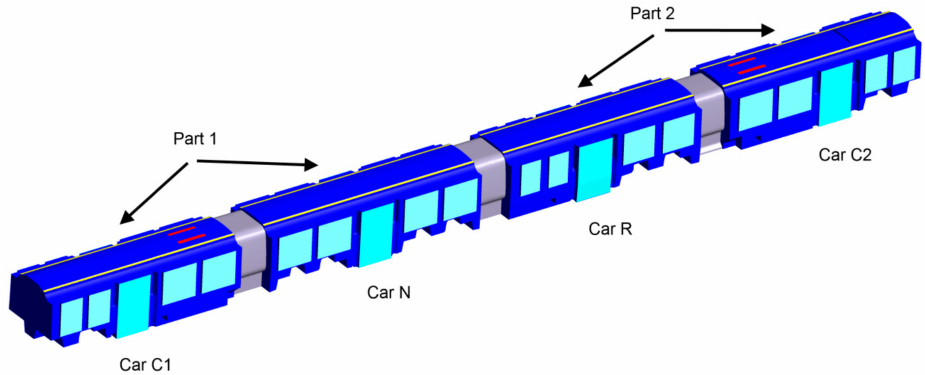
Figure 1. 3D railway vehicle model